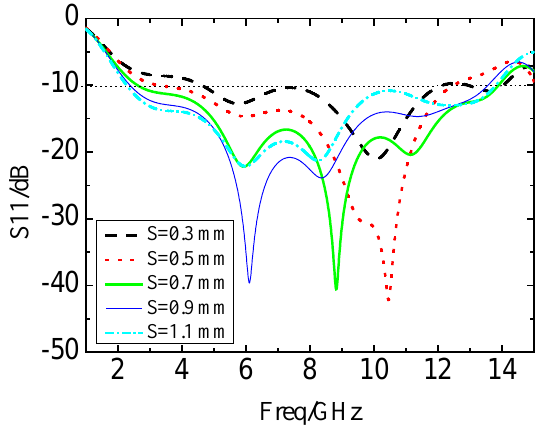
Figure 12. Simulation results of the reflection coefficient of the S changes.